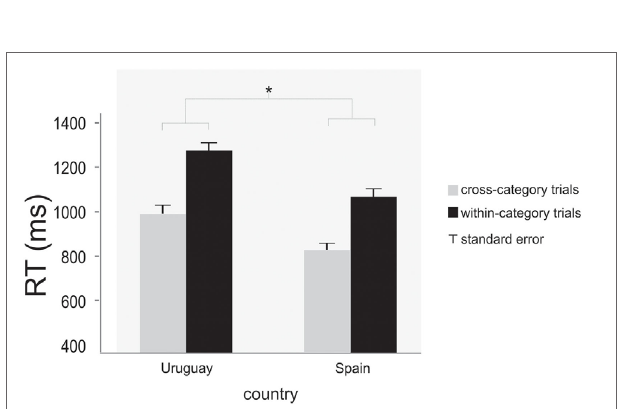
FigUre 4 | Mean differences in accuracy between cross- and within- category stimuli by country. Error bars represent